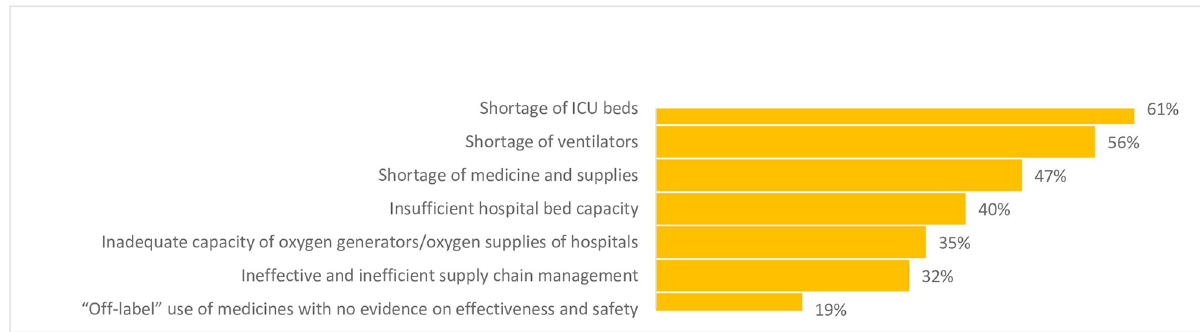
Fig 3. Challenges of hospitals in the EMR related to medicines, supplies, equipment (n = 139), July 2020.